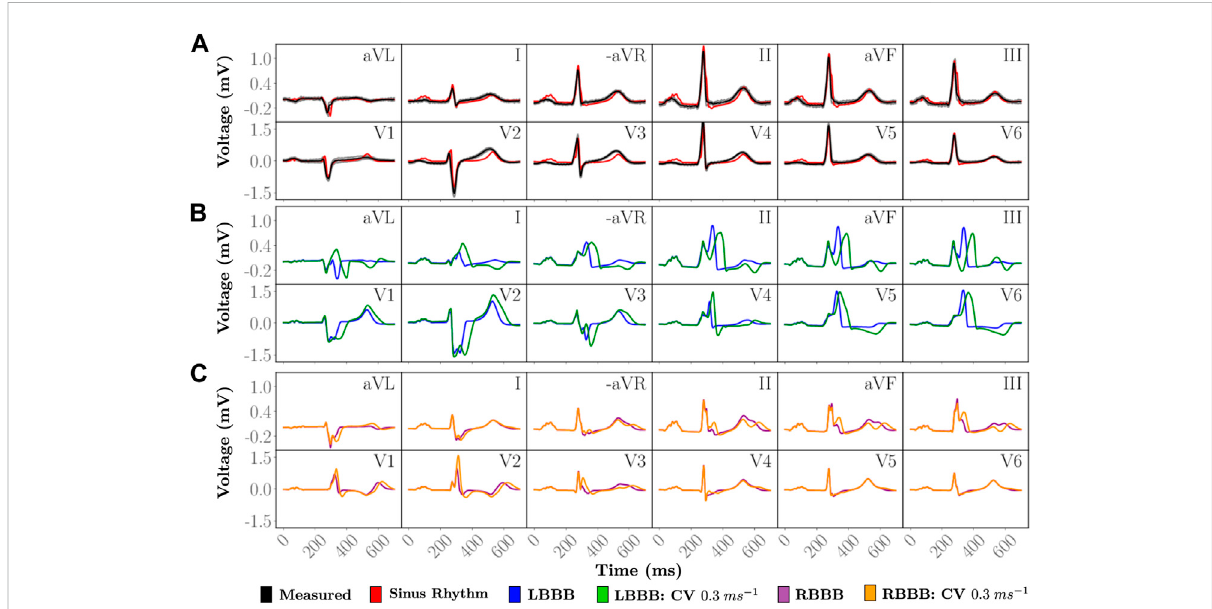
FIGURE 3 Simulated 12 lead ECGs of a single heartbeat. (A) The personalized heartbeat (red) during normal sinus rhythm is compared to an average heart beat in the measured data (black). Gray indicates 2 standard deviations from the average measured signal. Disease pathologies of (B) LBBB and (C) RBBB are comparedto the simulated 12 lead ECG under sinus rhythm. The simulated and measured signals under sinus rhythm have a QRS duration of 85 ms. Simulated LBBB ECGs have QRS durations of 127 and 178 ms with a ...longitudinal CV of 0.6 m/s and 0.3 m/s, respectively, within the LV. Simulated RBBB ECGs have QRS durations of 121 and 148 ms with a longitudinal CV of 0.6 m/s and 0.3 m/s, respectively, within the